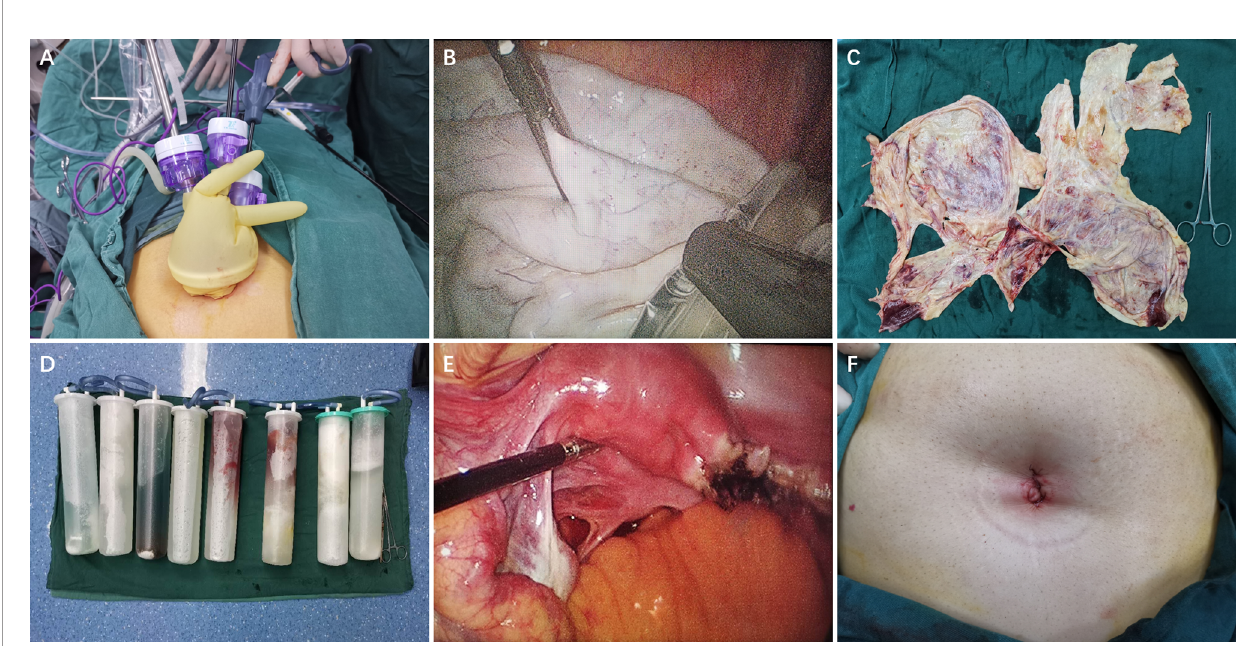
FIGURE 3 | (A) The instruments enter the abdominal cavity through single-port laparoscopic access. (B) The excised tissue was put into an endopouch specimen retrieval bag under laparoscope. (C) The wall of a giant cyst removed through the navel. (D) Intraoperative suction of intracapsular fl uid. (E) Unilateral salpingo-